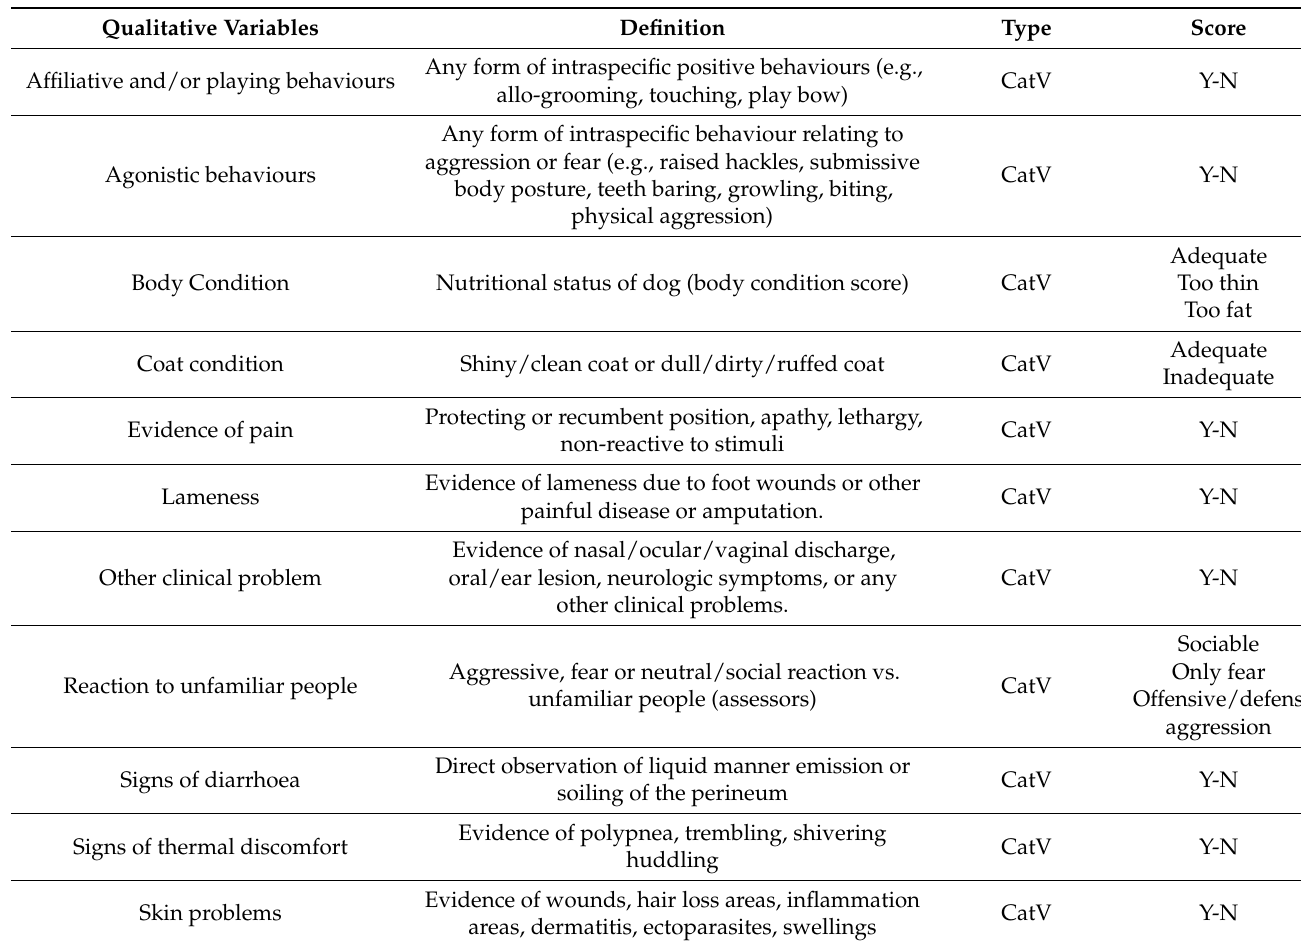
Table 1. Animal-based measures (ABMs) included in the protocol. CatV, categorical variable. Y-N, yes, no. When the assessment of a measure was not possible it was scored “not applicable”